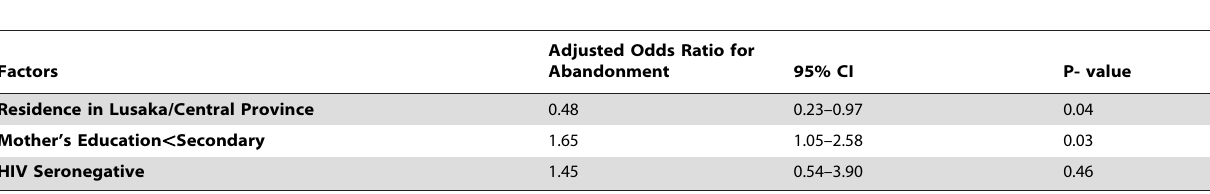
Table 3. Factors associated with abandonment or non-initiation of treatment: Proximate residence, HIV status, and maternal education as predictors in a multivariable